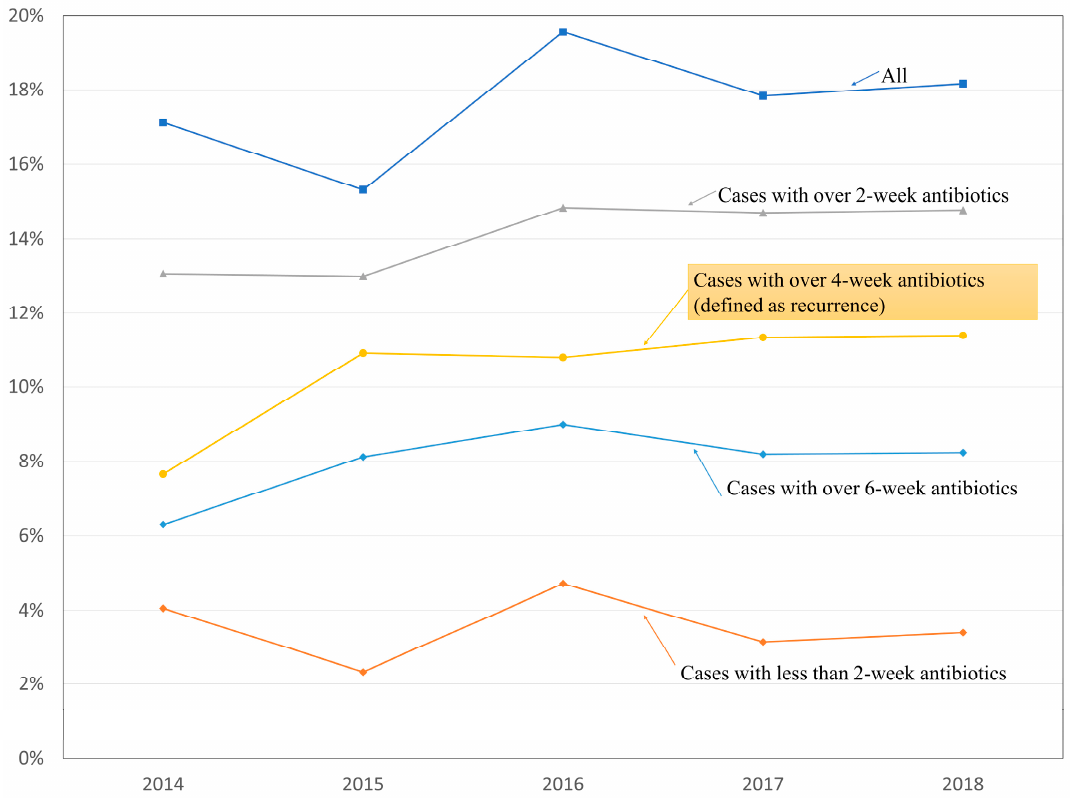
Figure 3. Recurrence rates based on the four definitions for pyogenic spondylodiscitis after early spinal instrumentation.